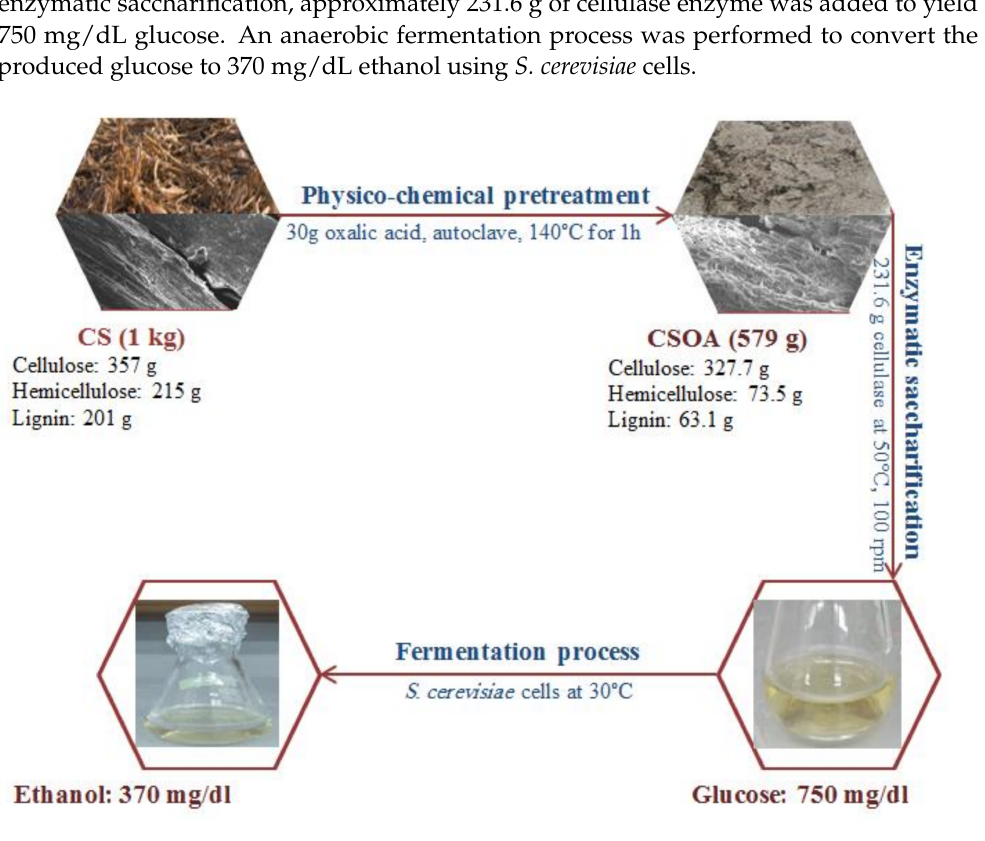
Figure 10. Mass balance for the production of bioethanol from corn